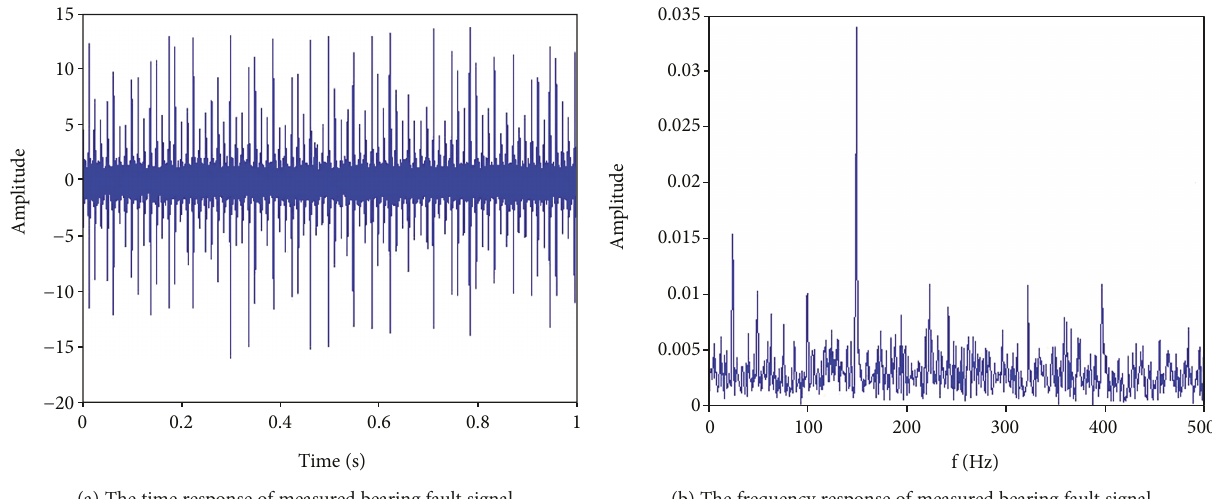
Figure 9: The time-frequency analysis of measured fault signal.